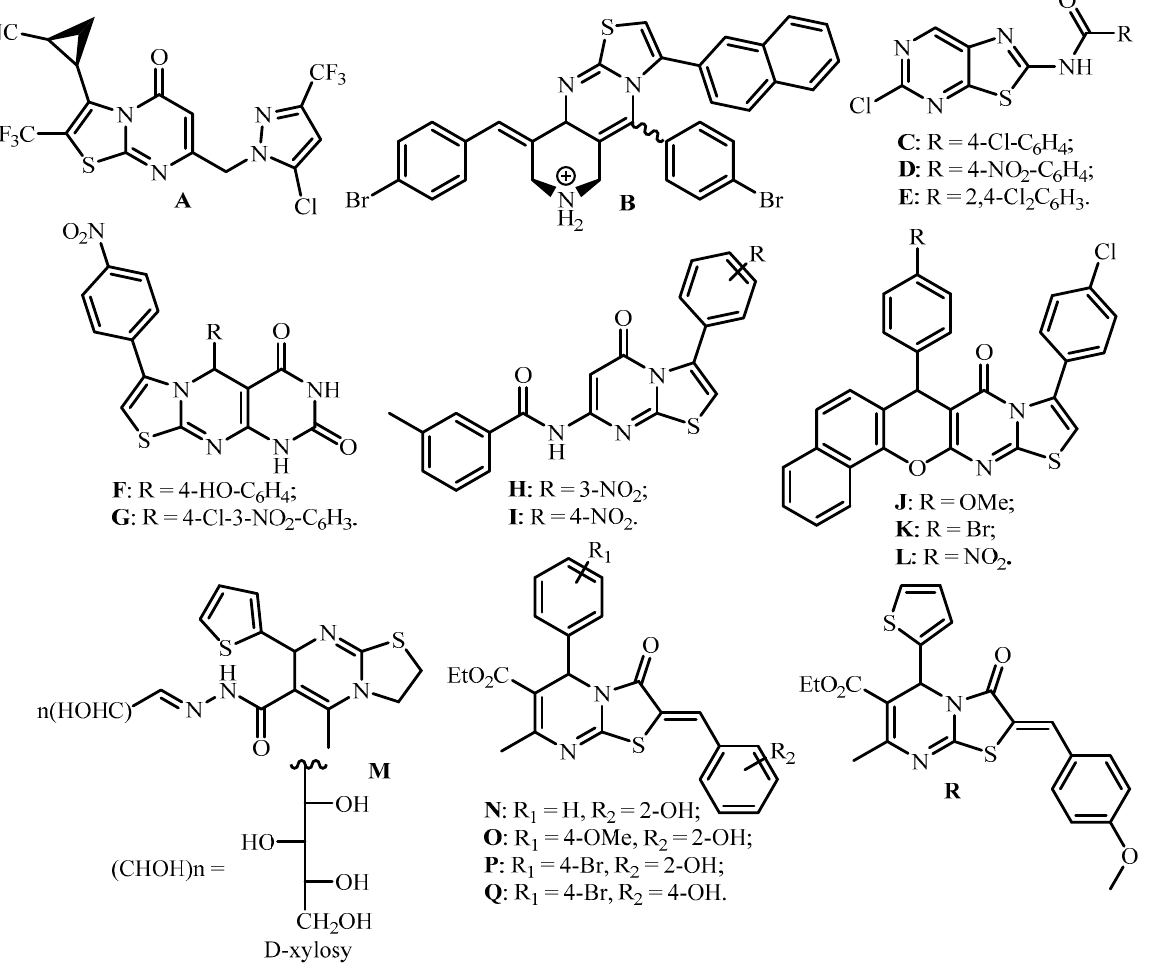
Figure 1. Thiazolopyrimidine compounds.